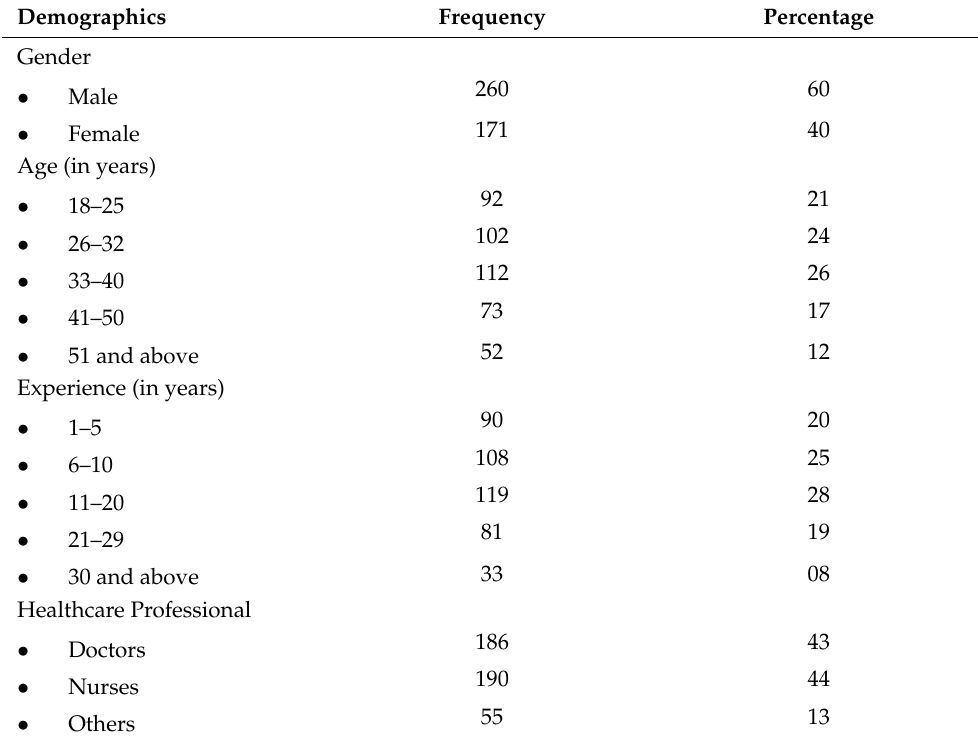
Table 2. Details of